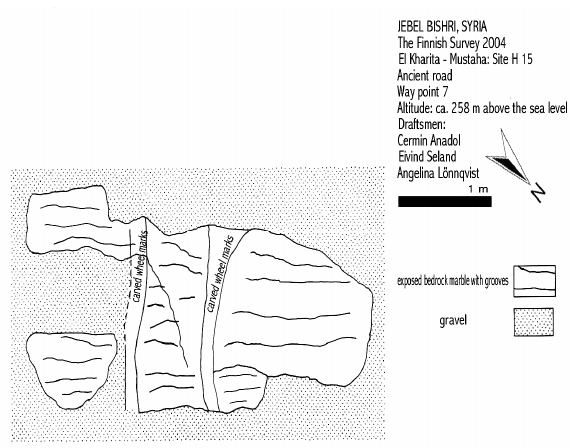
Figure 12. An ancient road H 15 with cart ruts cut into bed-rock on Jebel